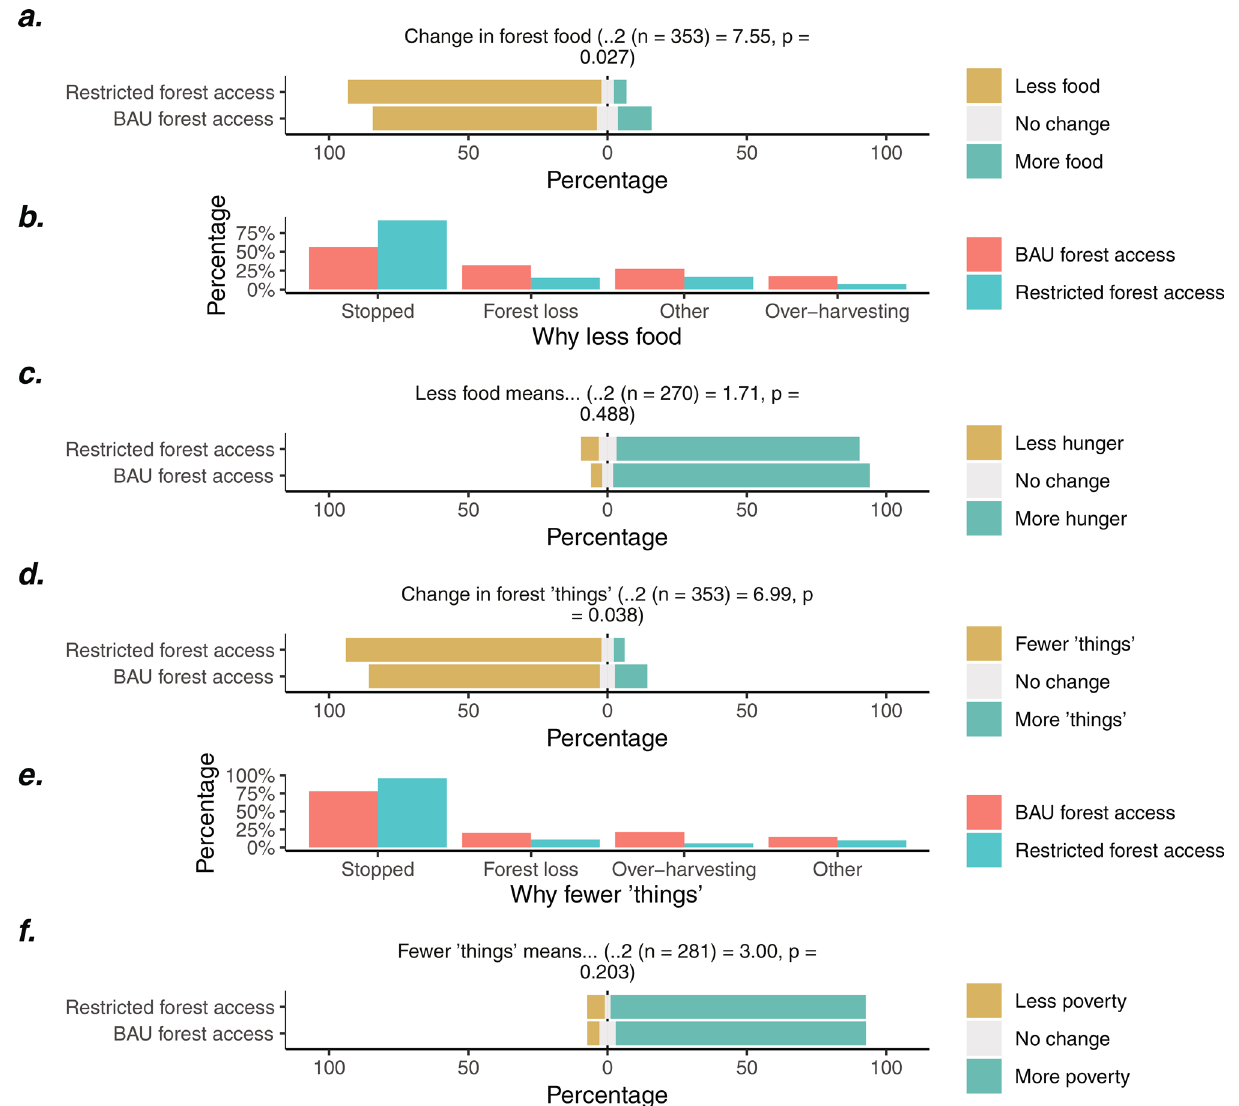
Figure 4. Scenario-based interview responses to two forest access scenarios. Panel a. describes expected changes in the amount of food from forests over the next decade, panel b. shows reported reasons for this decline, and panel c. illustrates expected consequences for household hunger (among forest users). Panel d. shows expected changes in the amount of income-generating ‘things’ from the forest, panel e. describes the reported reasons for this decline, and panel f. displays the expected consequences for household poverty (among forest users). Key: BAU =